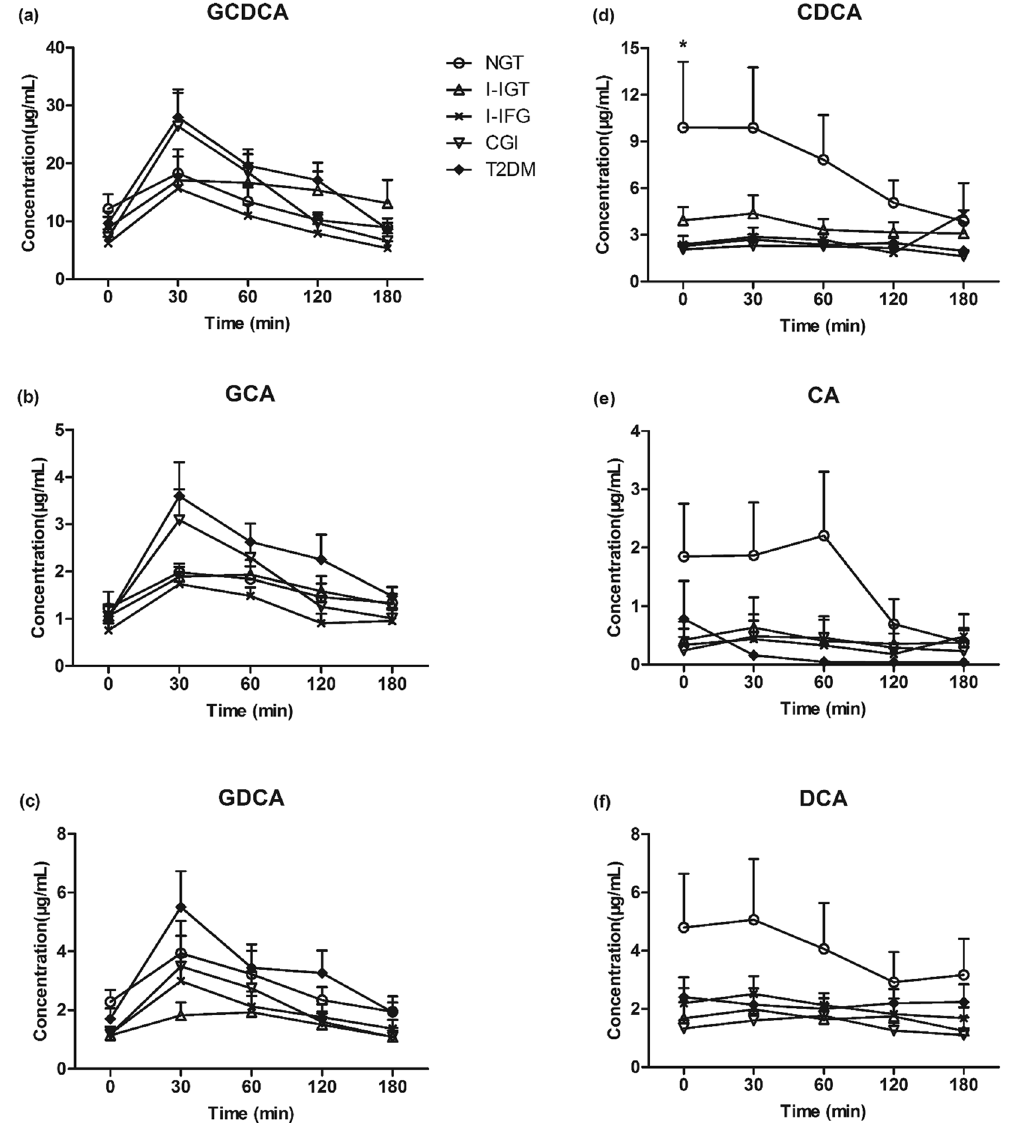
Figure 2. Dynamic change of serum GCDCA ( a ), GCA ( b ), GDCA ( c ), CDCA ( d ), CA ( e ) and DCA ( f ) in different glucose tolerance status after OGTT (n = 65). * P < 0.05 among the five groups.